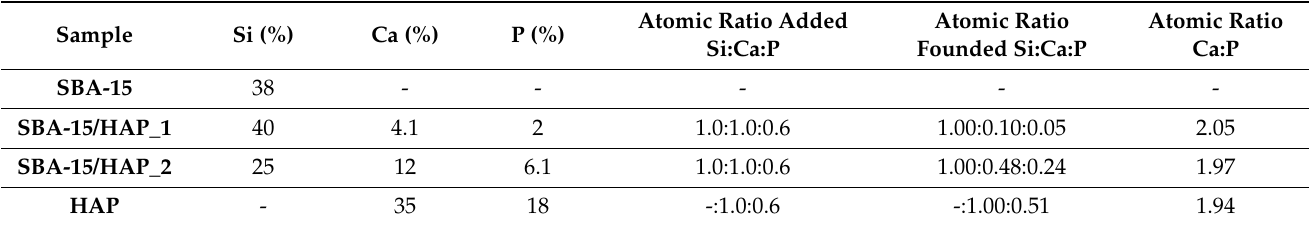
Table 1. Chemical analysis of materials in percentages and atomic ratios Si:Ca: theoretical and experimental P and the atomic ratio Ca:P. Sample